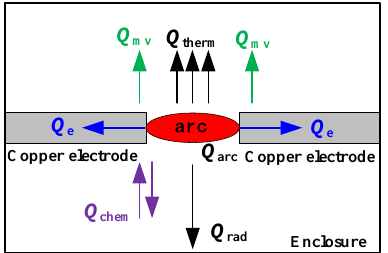
Figure 1. Simplified energy balance of the arc fault before the pressure relief device is open.